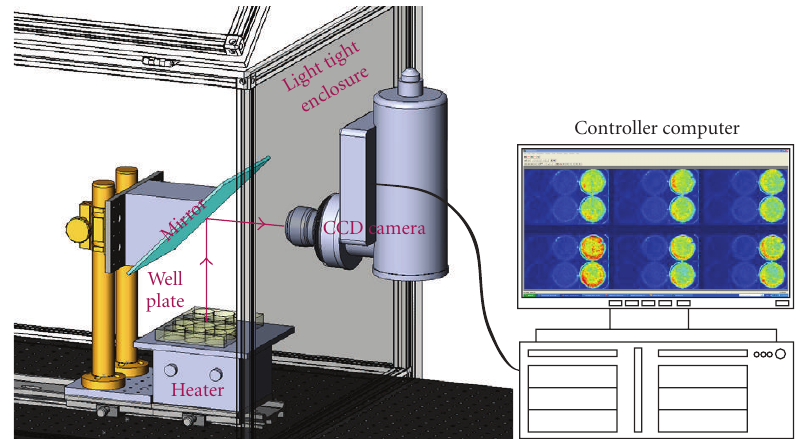
Figure 1: Diagram depicting the highly sensitive chemiluminescence imaging system.